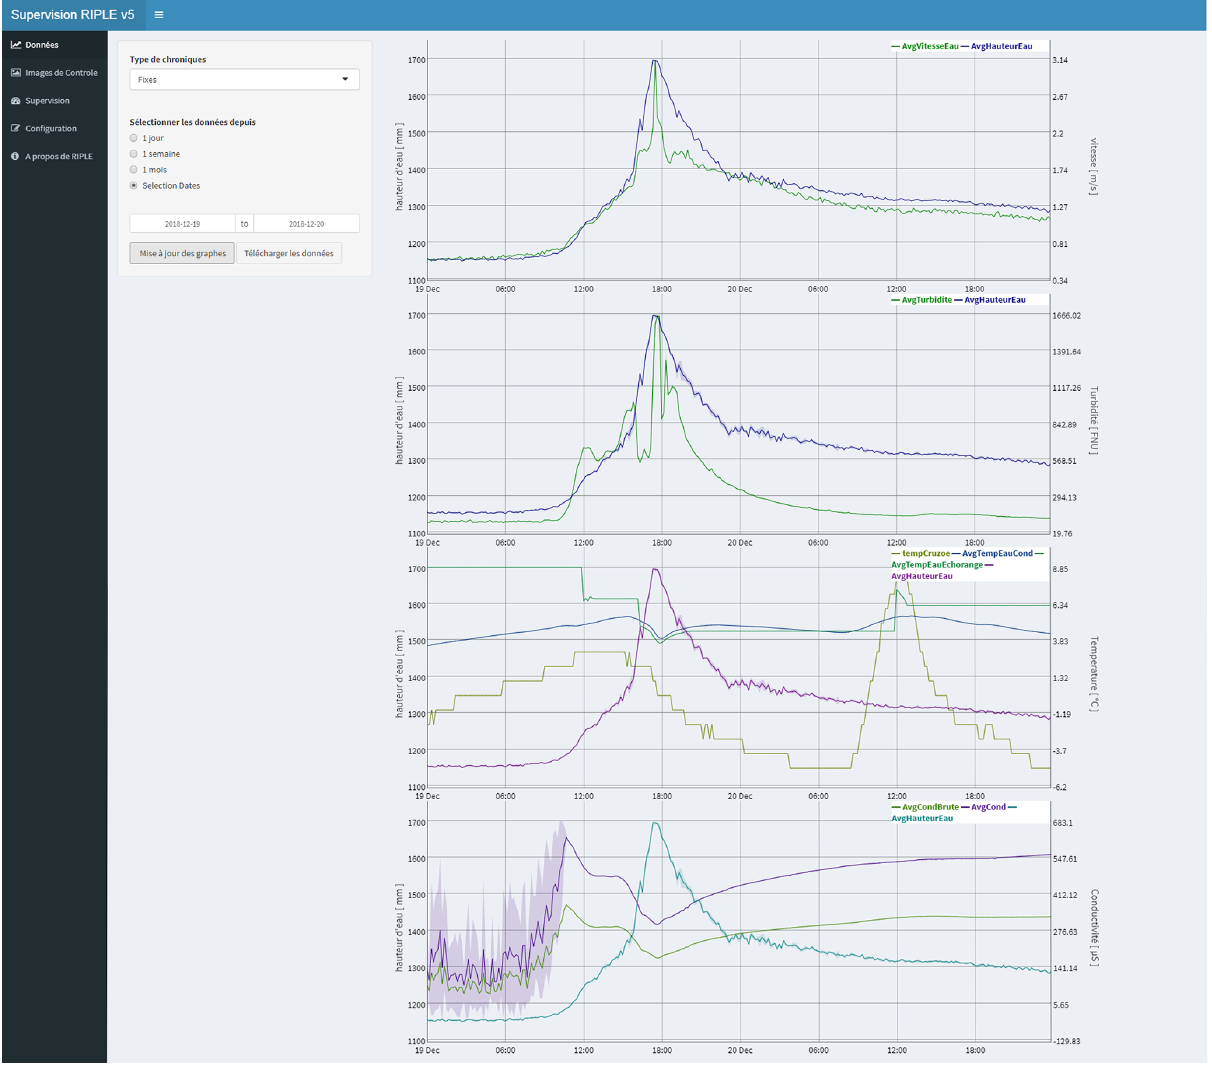
Figure 8. Screenshot of the “Data visualization” menu of the user interface in the default mode. Four time series graphs are displayed from top to bottom: (1) water level and surface water velocity, (2) water level and turbidity, (3) water level and temperature, and (4) water level and